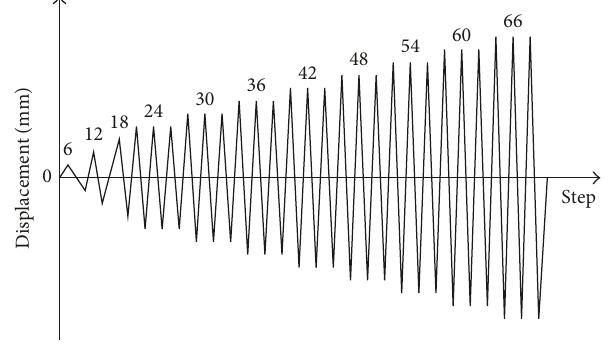
Figure 5: Loading